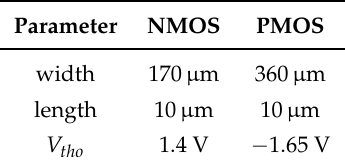
Table 4. MOSFET characteristics in CD4007UB.